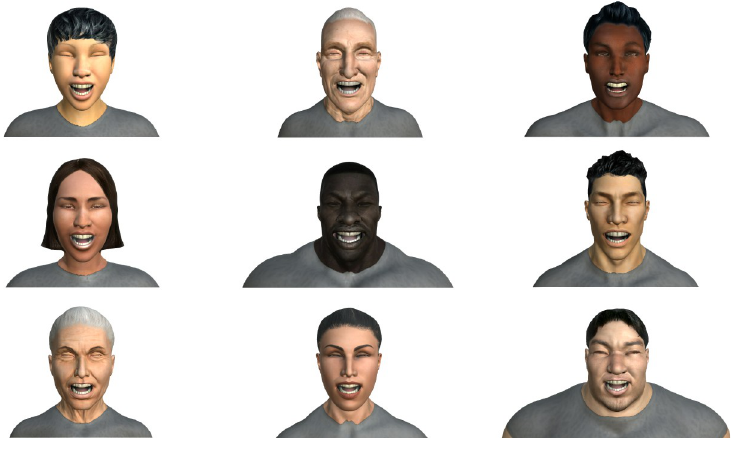
Fig 4. Reproduction of the Laughter expression on a six different